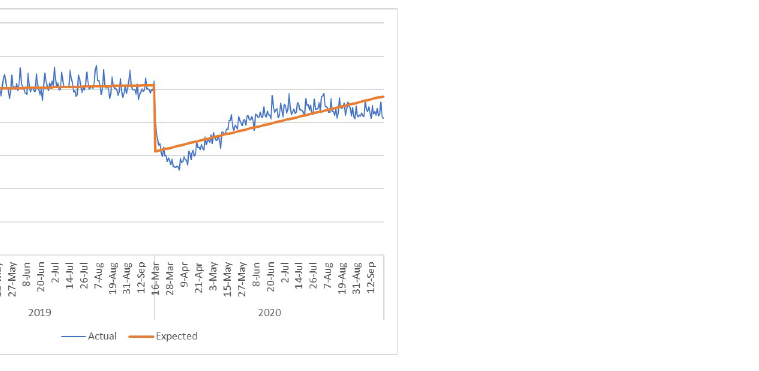
Fig 3. Number of emergency department visits per day for any reason.